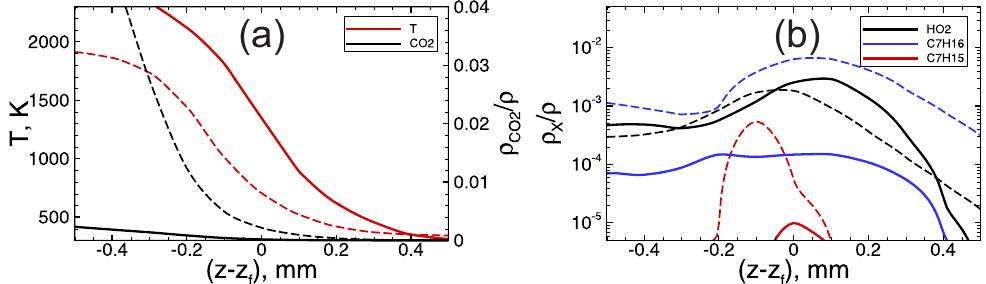
Figure 6. Temperature ( a ) and active radicals (( a )—CO 2 , ( b )—HO 2 , C 7 H 16 and C 7 H 15 ) profiles in the vicinity of the flame front ( z = z f ) in the foamed emulsion with 0.5 vol.% of heptane in the emulsion, foaming gas—0.5H 2 + O 2 mixture. Dashed lines—first stage of slow flame propagation. Solid lines—second stage of fast flame